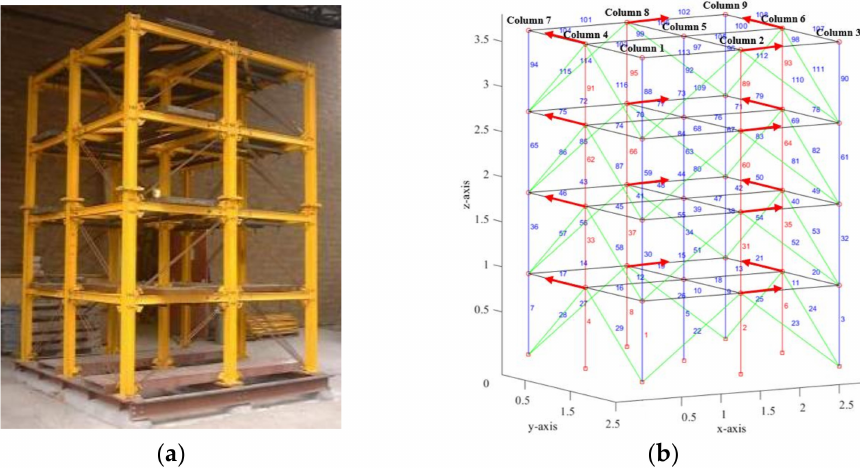
Figure 5. ASCE benchmark frame (unit: m). ( a ) test structure; ( b ) numerical